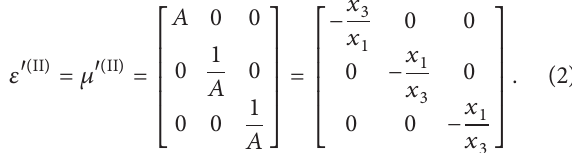
Figure 3: Schematic model to cloak a target object.